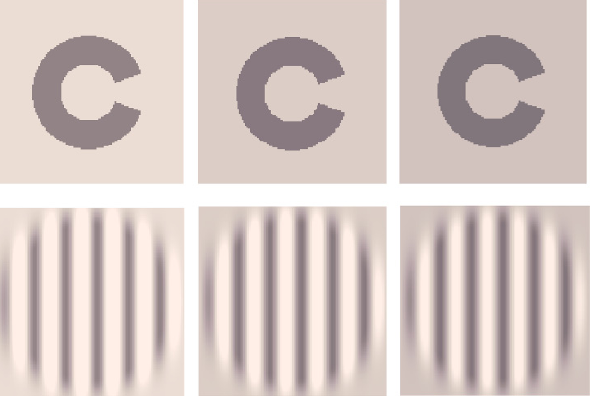
Figure 4. Graphic representation of a stimulus in three different devices with same DAC values.